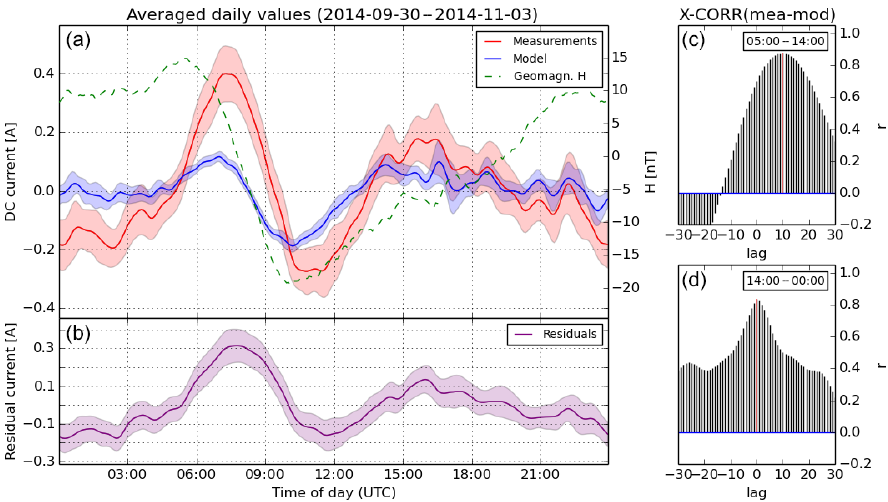
Figure 6. Panel (a) displays the averaged daily variations in measured DC currents (red) and the model results (blue) with 95% confidence intervals, while (b) shows the averaged residuals between the measurements and models, revealing signals that are not covered by the model. (c, d) The cross-correlation between model and measurements within the diurnal signal (c) and outside (d) , with the maxima highlighted in red.